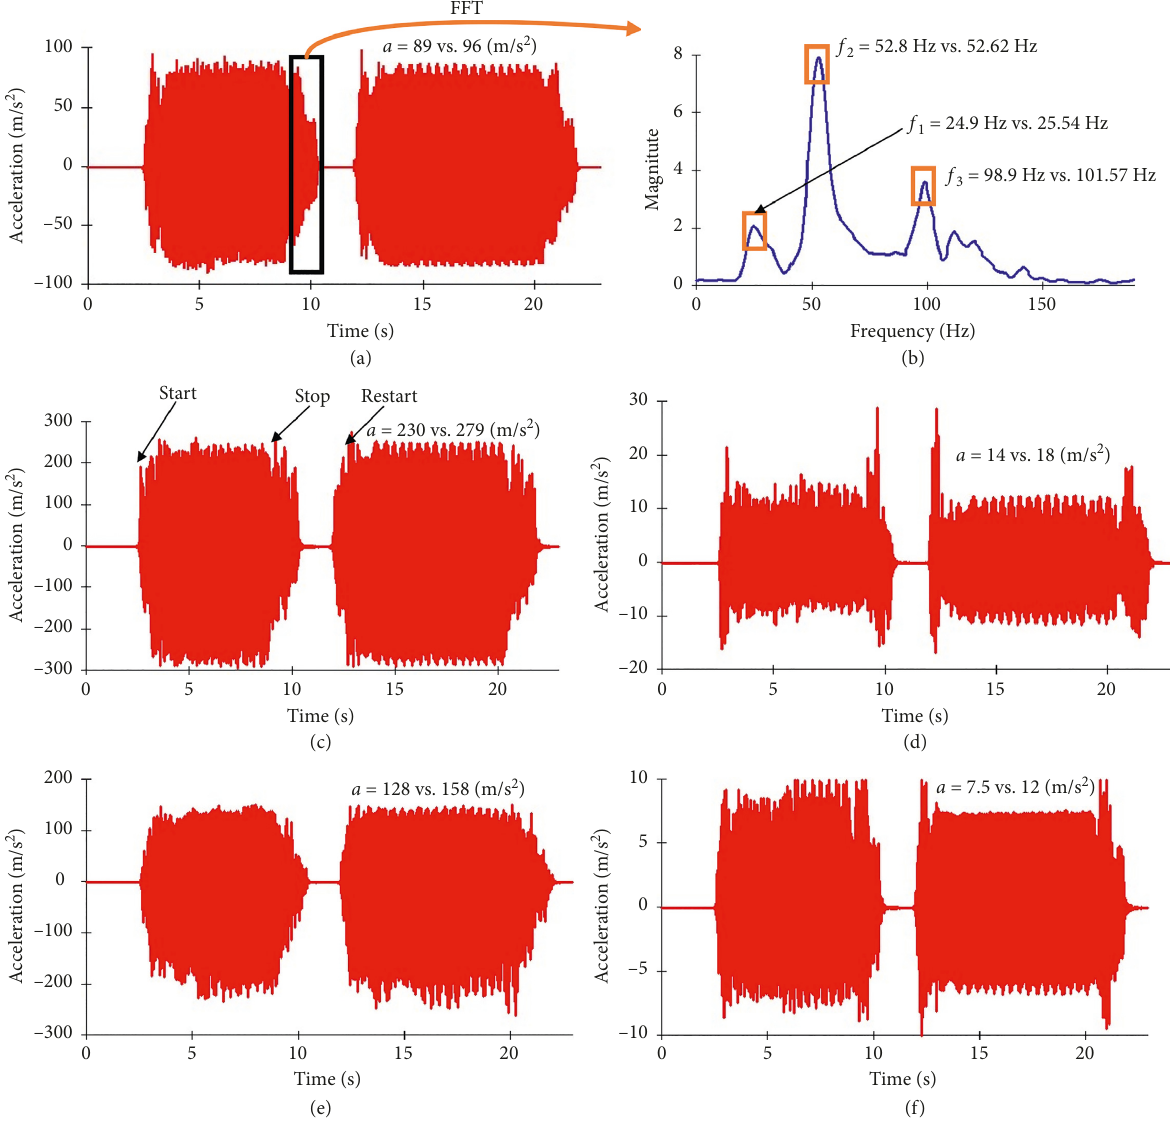
Figure 5: Experiment results: (a) signal of sensor No.1; (b) FFTresults of the free decay signal; (c) signal of sensor No. 2; (d) signal of sensor No. 3; (e) signal of sensor No. 4; (f) signal of sensor No.